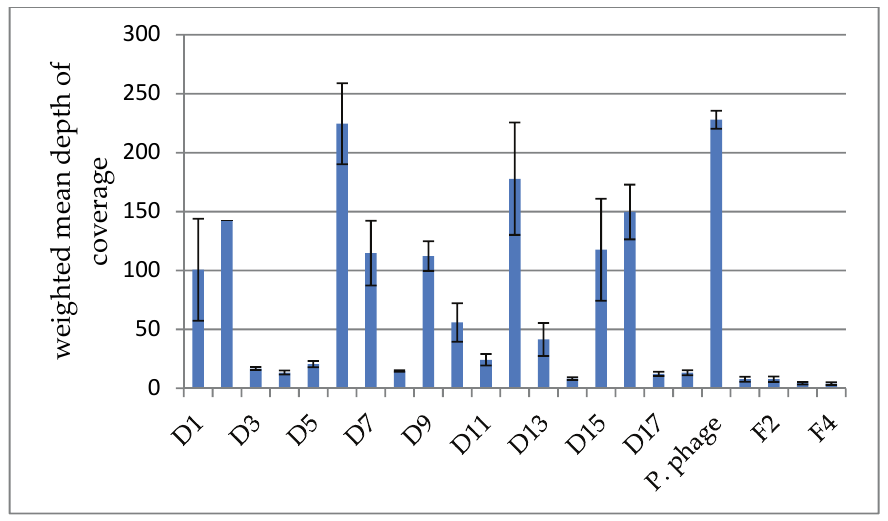
Figure 2. Comparison of the weighted mean of the depth of coverage between clusters in the Intesti sample. The weighted standard deviation is depicted as error bars. Note that cluster D2 is composed of only one contig and the standard deviation is therefore not applicable. It can be seen that the depth varies greatly between clusters, reflecting the different abundances of the represented phage types in the cocktail.